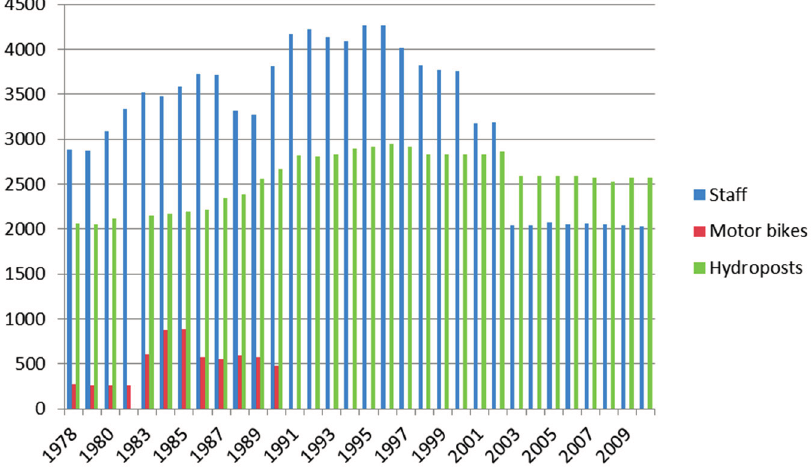
Figure 8. Dynamics of supply side control-surveillance and guards in Ferghana Province (total